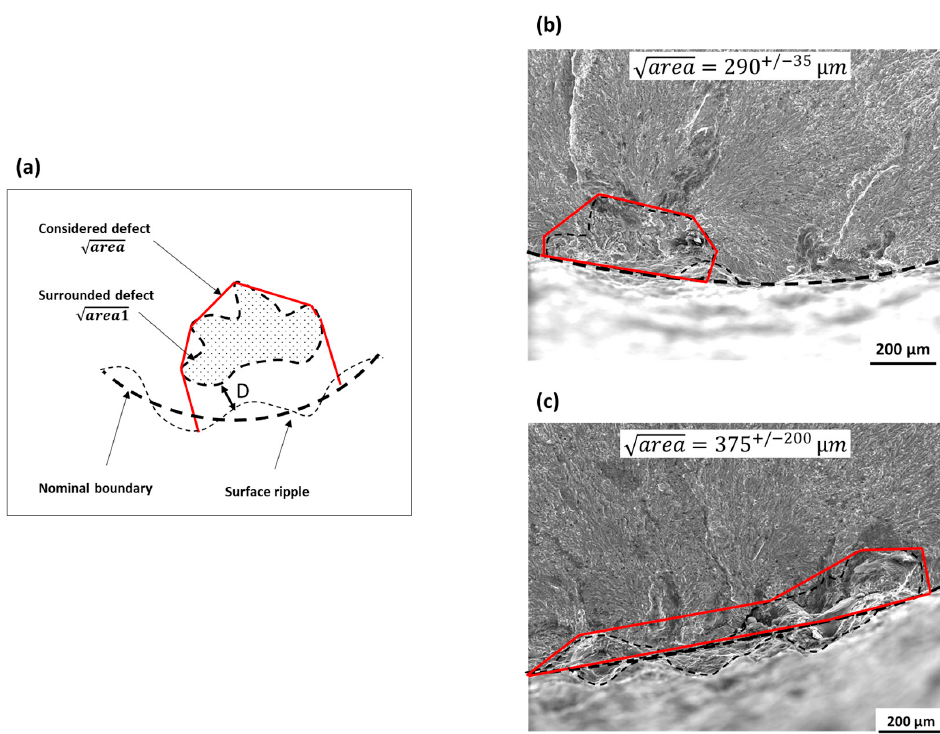
Figure 9. ( a ) Estimation of the defect size depending on its location relative to the free surface, ( b , c ) quantification of defect size on fracture surfaces of AB-Z-T6, ( b ) 110 MPa, 300,000 cycles and ( c ) 100 MPa, 800,000 cycles.